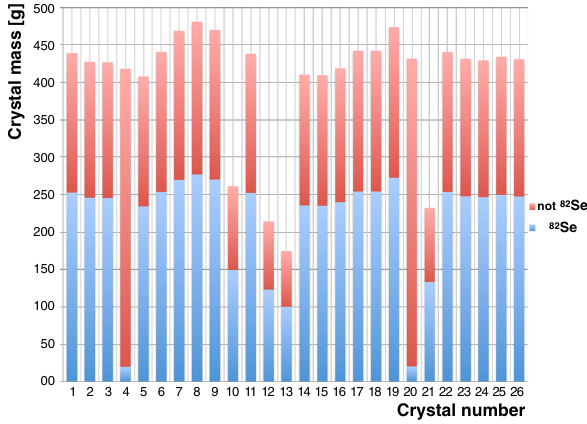
Fig. 4 Crystal masses. The 82 Se content for each crystal is